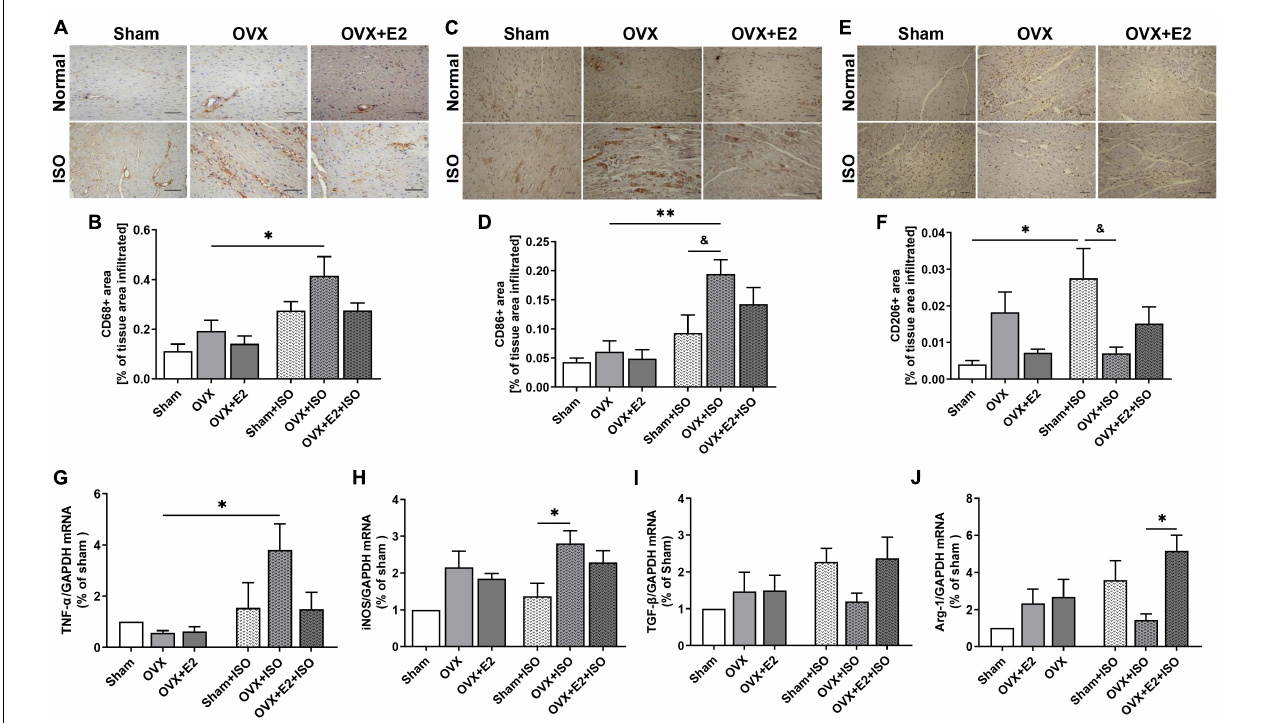
FIGURE 4 | Estrogen attenuates maladaptive myocardial inflammatory responses chronic stress. (A,B) Representative immunohistochemical staining and graphical presentation of CD68-positive cells (whole macrophages) assessed from the myocardia. (C,D) Representative immunohistochemical staining and graphical presentation of CD86-positive cells (proinflammatory phenotype/M1 macrophages) assessed from the myocardia. (E,F) Representative immunohistochemical staining and graphical presentation of CD206-positive cells (anti-inflammatory phenotype/M2 macrophages) assessed from the myocardia ( n = 6–8 field of view/6–8 sections/6 hearts/group). (G,H) Graphical presentation of M1 macrophage markers, tumor necrosis factor-alpha (TNF- α ), and inducible nitric oxide synthase (iNOS) mRNA expressions assessed by RT-qPCR ( n = 4 hearts/group). (I,J) Graphical presentation of M2 macrophage markers, transforming growth factor-beta (TGF- β 1), and arginase 1 (Arg-1) mRNA expressions assessed by RT-qPCR ( n = 5 hearts). ∗ p < 0.05 and ∗∗ p < 0.01; & p < 0.05. Data are presented as mean ± SEM. Data were analyzed using two-way ANOVA and Bonferroni’s multiple comparisons